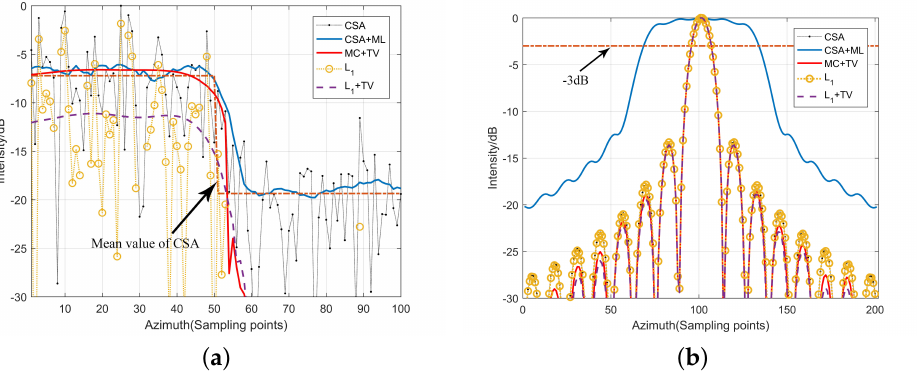
Figure 7. The slice along the azimuth direction of data 2. ( a ) The edge of the rainforest. ( b ) The simulated point